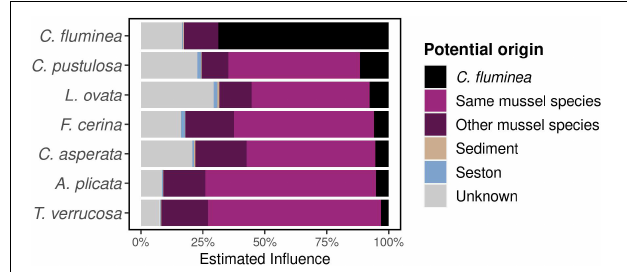
FIGURE 5 | Influence of co-occurring host-associated, seston, and sediment microbes over individual microbiomes, estimated using FEAST software and averaged per species. Globally, individual bivalves presenting a higher reciprocal influence (native mussels over C. fluminea , and reversely) presented a higher phylogenetic richness (Pearson’s correlation test on log-transformed data, P < 0.001, r =